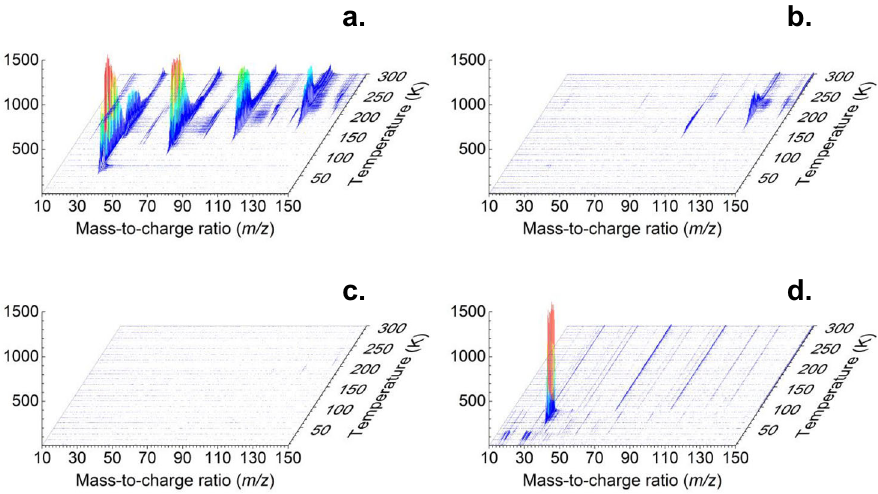
Fig. 3 Mass spectra showing the temperature-programmed desorption (TPD) pro fi les for the electron processed phosphine – nitrogen ices. The data were recorded via photoionization re fl ectron time-of- fl ight mass spectrometry (PI-ReTOF-MS) at photon energies of ( a ) 10.49 eV; ( b ), 8.53 eV; ( c ), 8.20 eV; ( d ), blank, 10.49